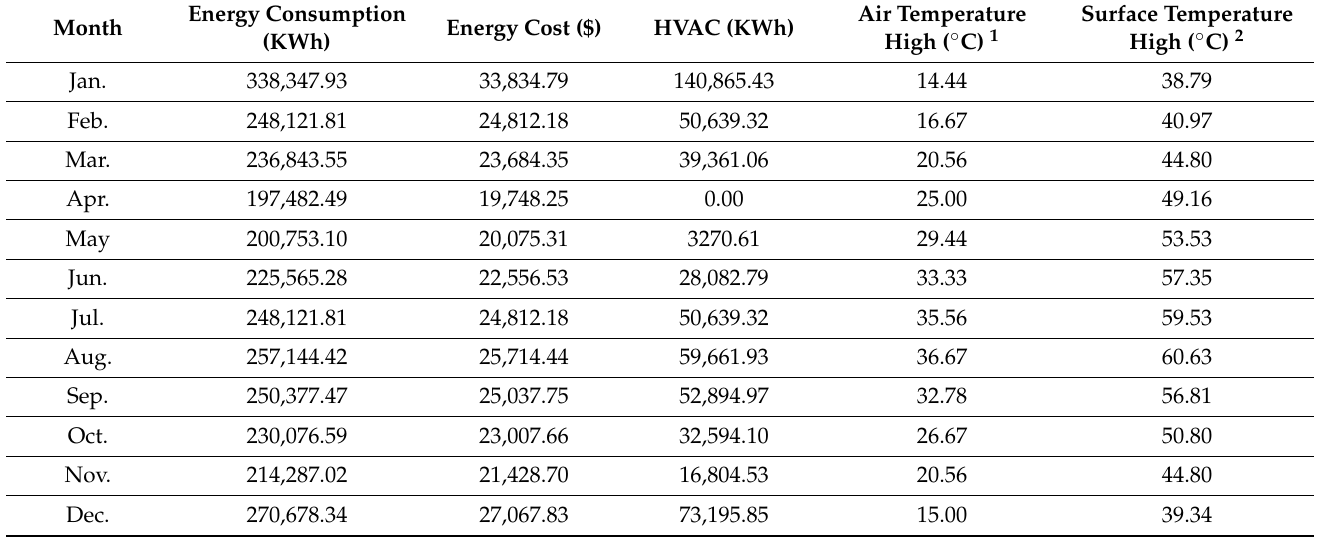
Table 2. Energy consumption data of the subject building in Texas.